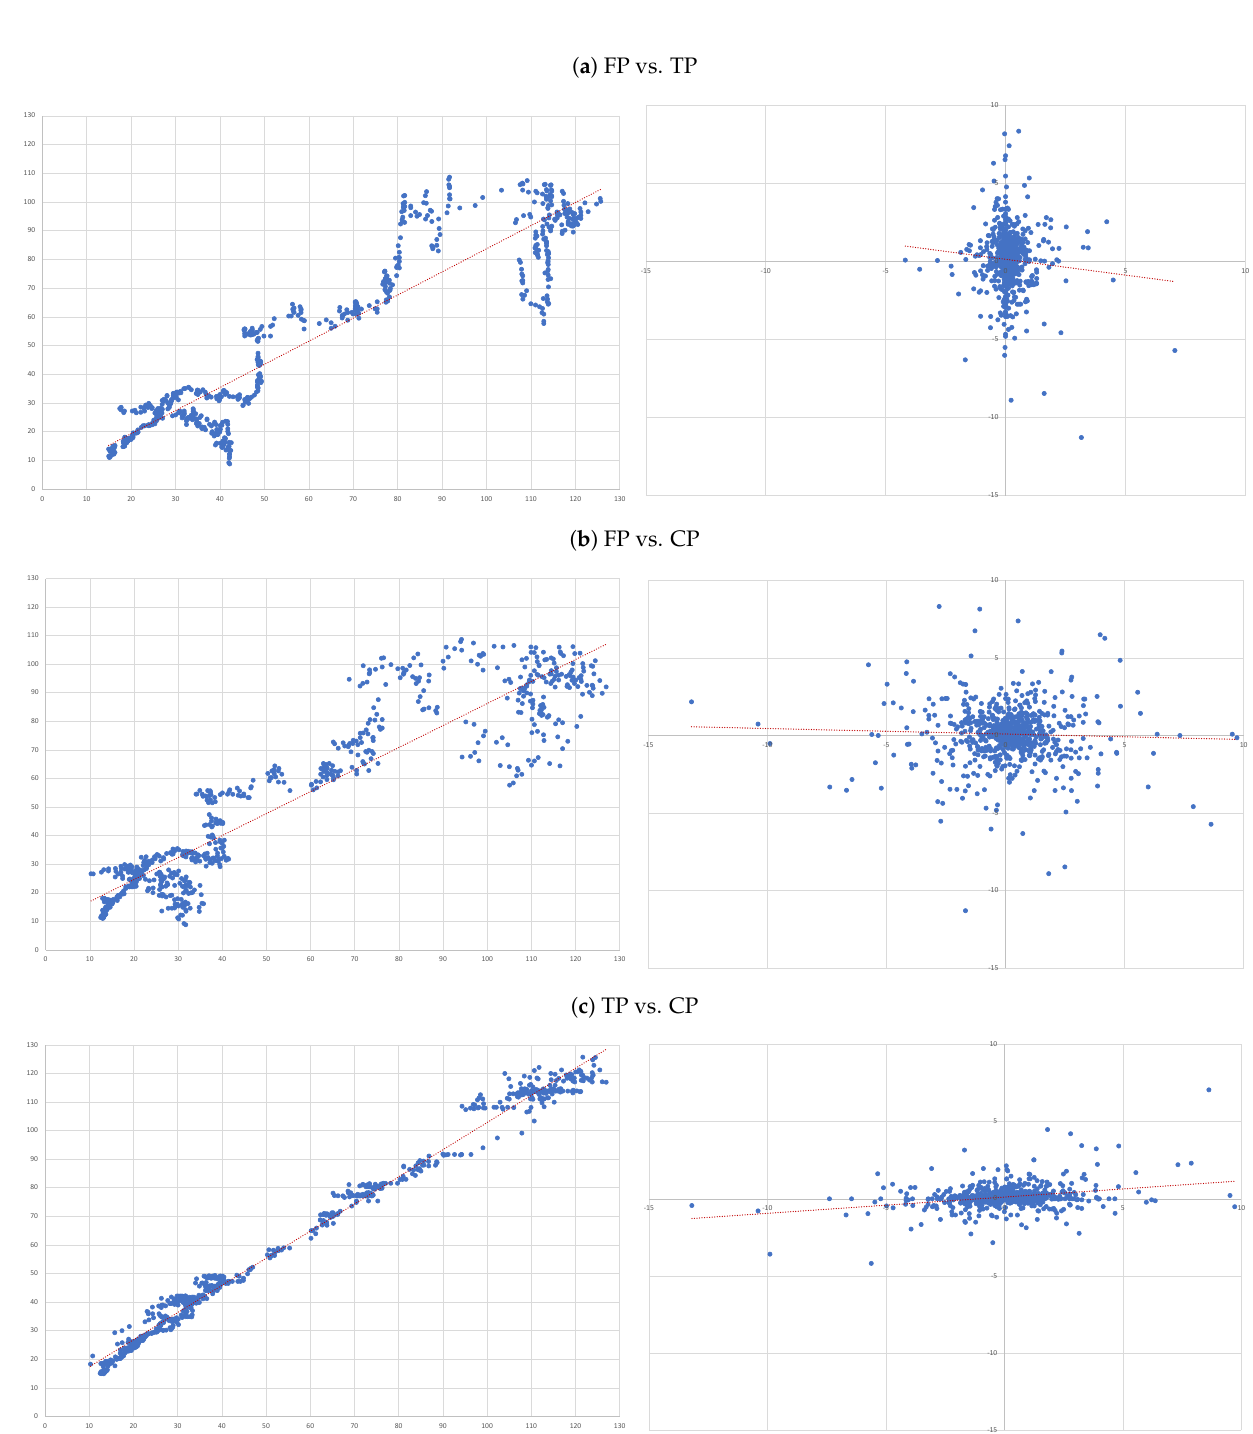
Figure A2. Anheuser. Individual time series regressions using three price series on Anheuser: future prices (FP), target prices (TP), and capitalised prices (CP) forecasts. On the left-hand-side images of level regressions and on the right-hand-side of regressions in